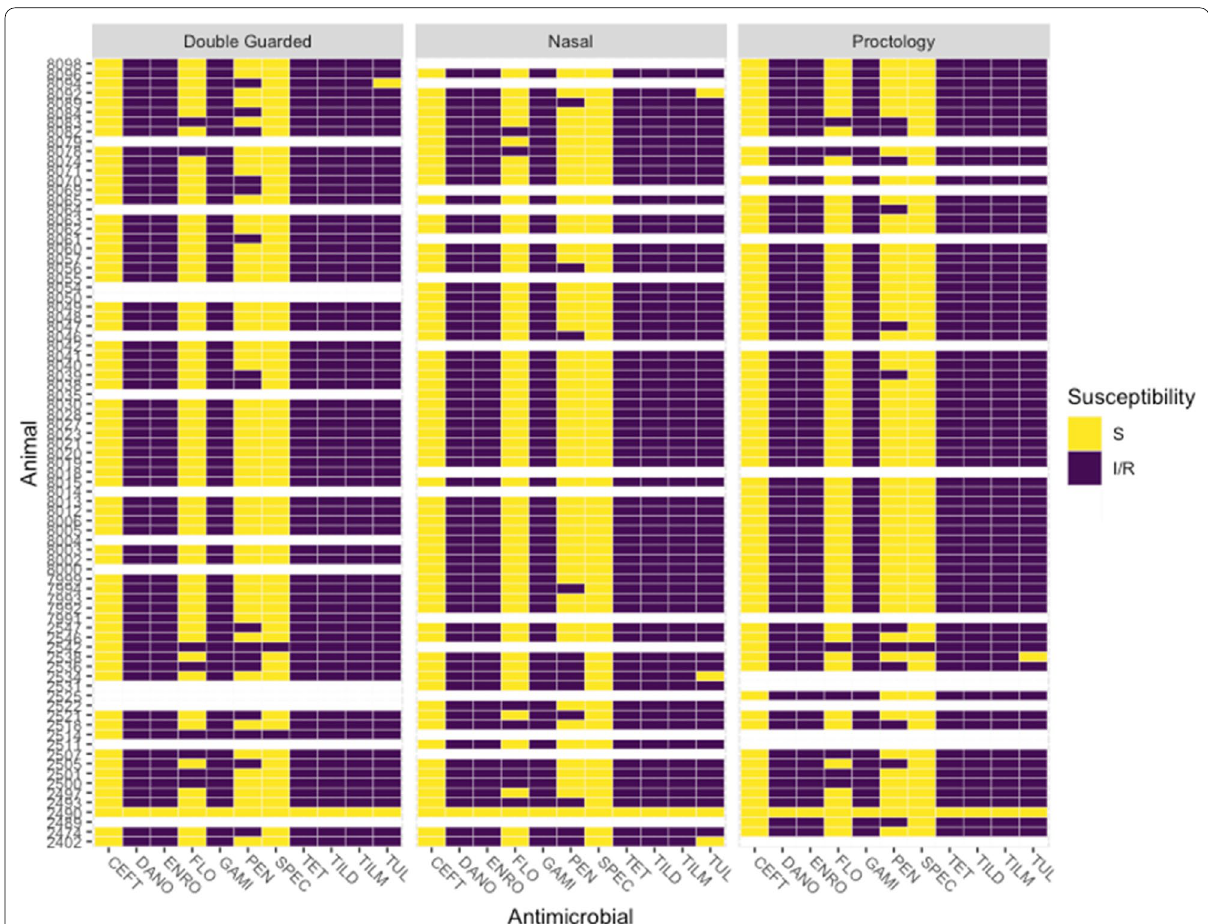
Fig. 1 Antimicrobial resistance patterns of M. haemolytica isolated from each calf separated by swab type. Each isolate is identified by the calf from which it was isolated. Blank lines indicate calves that did not have M. haemolytica isolated from that swab, though it was M. haemolytica positive via (an)other swab type(s). S susceptible, I/R intermediate or resistant, CEFT ceftiofur, DANO danofloxacin, ENRO enrofloxacin, GAMI gamithromycin, PEN penicillin, SPEC spectinomycin, TET tetracycline, TILD tildipirosin, TILM tilmicosin, TUL